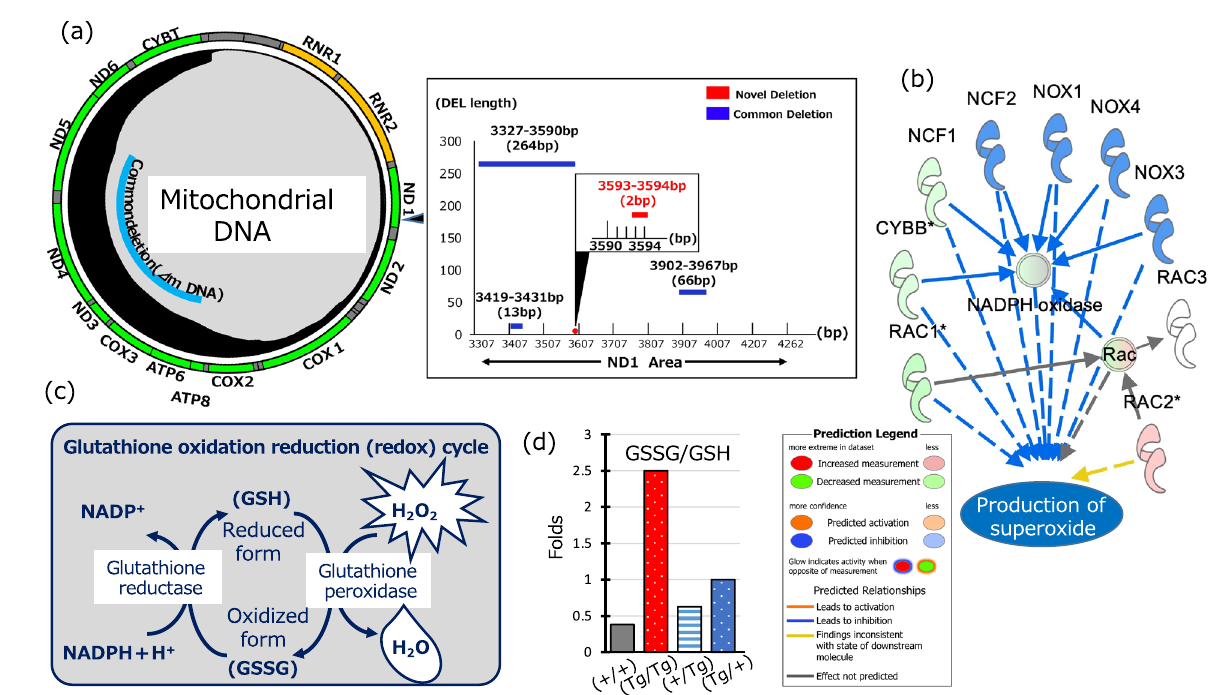
Figure 6. mtDNA mutational analysis and ROS levels. ( a ) ND1 mutation site in (Tg/Tg) fish corresponding to human mtDNA was analyzed using the mtDNA breakpoints database (Mito Break; mitobreak.portugene. com). The black line in the circle (mtDNA) shows a historical record of mtDNA mutations. The black rectangle indicates the novel mutation. ( b ) Re-analysis of gene expression in (Tg/Tg) and (+/+) fish using previously reported data 18 using IPA. This figure was created using Ingenuity Pathway Analysis (IPA) Content version: 57662101, QIAGEN (https:// qiagen. secure. force. com/ Knowl edgeB ase/ Knowl edgeI PAPage). Relationship between NADPH oxidase gene and superoxide production as predicted by IPA. NCF1 (0.99-fold downregulation), CYBB (0.77-fold downregulation), RAC1 (0.58-fold downregulation), and RAC2 (1.46-fold upregulation) are components of NADPH oxidase. The asterisk indicates multiple IDs in the data set, and the data are displayed as the mean. Double circles indicate complexes of multiple genes. ( c ) Summary of the glutathione oxidation–reduction cycle. ( d ) Ratio of GSSG/GSH in (+/+), (Tg/Tg), (+/Tg), and (Tg/+) fish using capillary electrophoresis–mass spectrometry. The concentrations of GSSG and GSH in these fish are listed in “Supplementary mitochondrial biogenesis, respiration, thermogenesis, and gluconeogenesis 24 and acts as a potent regulator of ROS removal via upregulation of various ROS-detoxifying enzymes 25 . Multiple pathways can stimulate PGC-1α in response to low NAD + levels, and there is crosstalk between PGC-1α and OPA1. The signal transduction pathway between them is complex and involves both stimulation and downregulation, rather than only the conversion of PGC-1α to OPA1 26 . At least 21 pathways exist from PGC-1α to OPA1, and 29 pathways from OPA1 to PGC-1α (Fig. 3c, Supplementary Table 3). OPA1 is localized on the inner mitochondrial membrane and regulates the equilibrium between mitochondrial fusion and fission and is, therefore, essential for maintaining mitochondrial function 27 . As ATP production was found to be associated with OPA1 26,28,29 , increased OPA1 expression in (Tg/ Tg) fish indicates an increase in ATP synthase expression and has a central role in the coordinated regulation of mitochondrial structure and function 26 . Notably, there were differences in the five protein signals corresponding to OPA1 in mice 27 . (Tg/Tg) fish showed a different intensity band signal than (+/+) fish. The exact banding pat- tern was difficult to determine due to the strong band intensity of (Tg/Tg) fish (“Supplementary Information”). The reason for this needs to be investigated in the future. Thus, mitochondrial fusion may compensate for the shortage of ATP resulting from dysfunctional mitochondria (Fig. 2e,f). Upregulation of PGC-1α and OPA1 is observed in hypoglycemia (Fig. 3c) 28,30 , consistent with previous data (Fig. 3a) 18 in terms of enhancing β-oxidation and promoting the TCA cycle for ATP production. Therefore, a decreased NAD + /NADH ratio is predicted to be the key regulator of this phenomenon [observed in (Tg/Tg) and (Tg/+) GH-transgenic fish]. Moreover, this phenomenon is inherited by the future generations of female GH-transgenic fish and male offspring, who will not pass it on to their offspring. If this hypothesis is correct, a low NAD + /NADH ratio will increase the expression of PGC-1α and OPA1 in these two types of fish. Inducing the expression of these genes leads to TCA cycle activation, resulting in hypoglycemia and decreased ROS levels in (Tg/Tg) and (Tg/+) fish. Indeed, blood glucose levels were significantly decreased in these transgenic fish (Fig. 1b,c). Collectively, our results indicate a dysfunctional ND1 site. As the loss of mtDNA-encoded ND1 results in the disruption of complex I 31 , it also affects the activities of other respiratory chains, resulting in mitochondrial dysfunction. Therefore, (Tg/Tg) and (Tg/+) fish may be